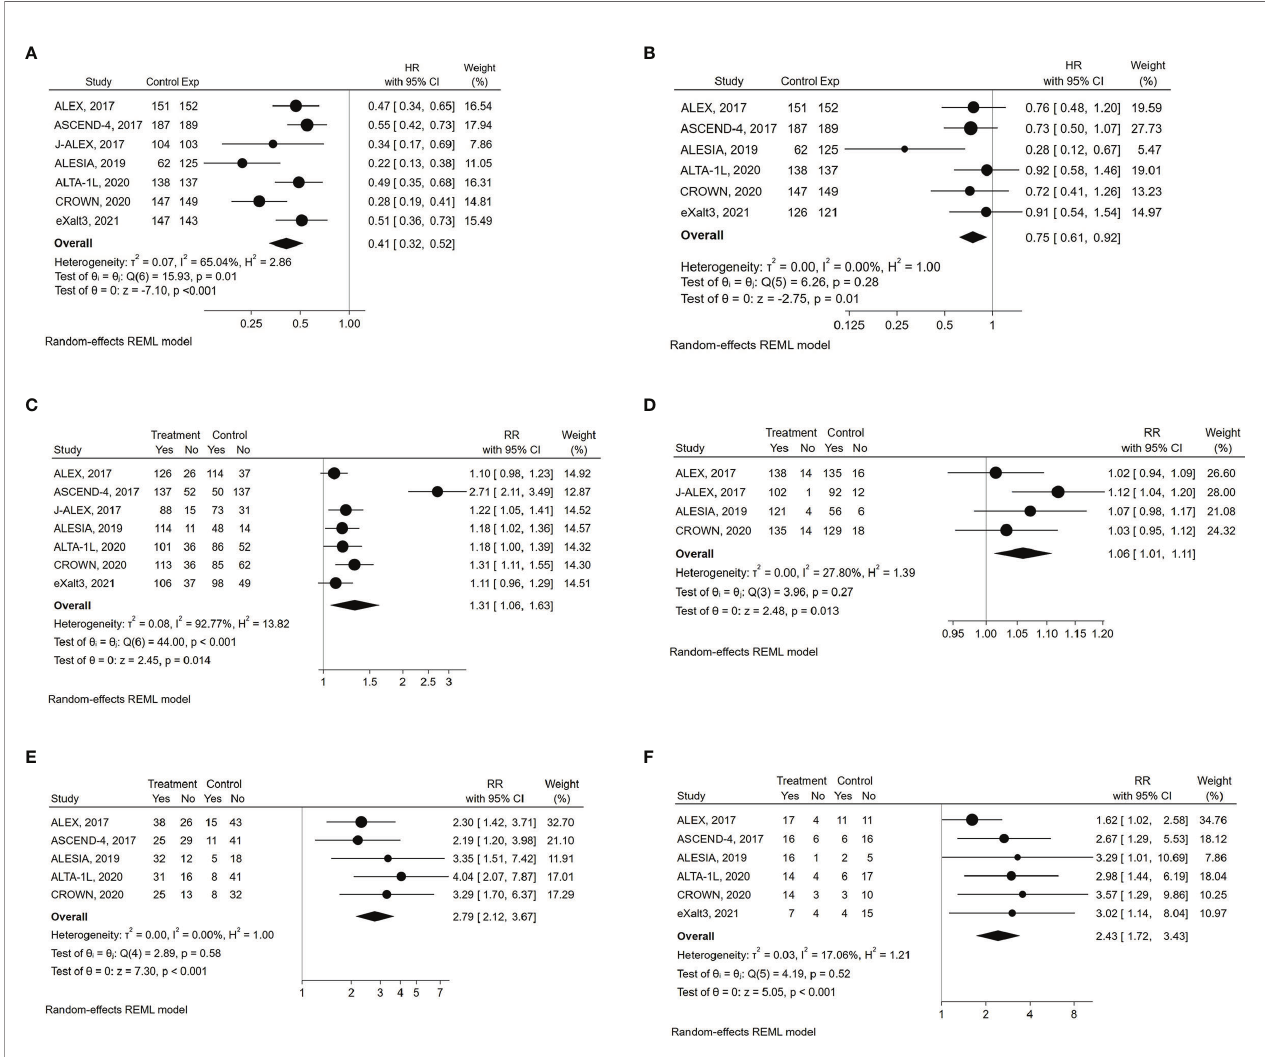
FIGURE 2 | Forest plots of HR (hazard ratio) and RR (relative risk) for ef fi cacy outcomes associated with next-generation ALKIs compared to control therapies. (A) PFS (progression ‐ free survival). (B) OS (overall survival). (C) ORR (overall response rate). (D) DCR (disease control rate). (E) aCNSRR (any lesion of central